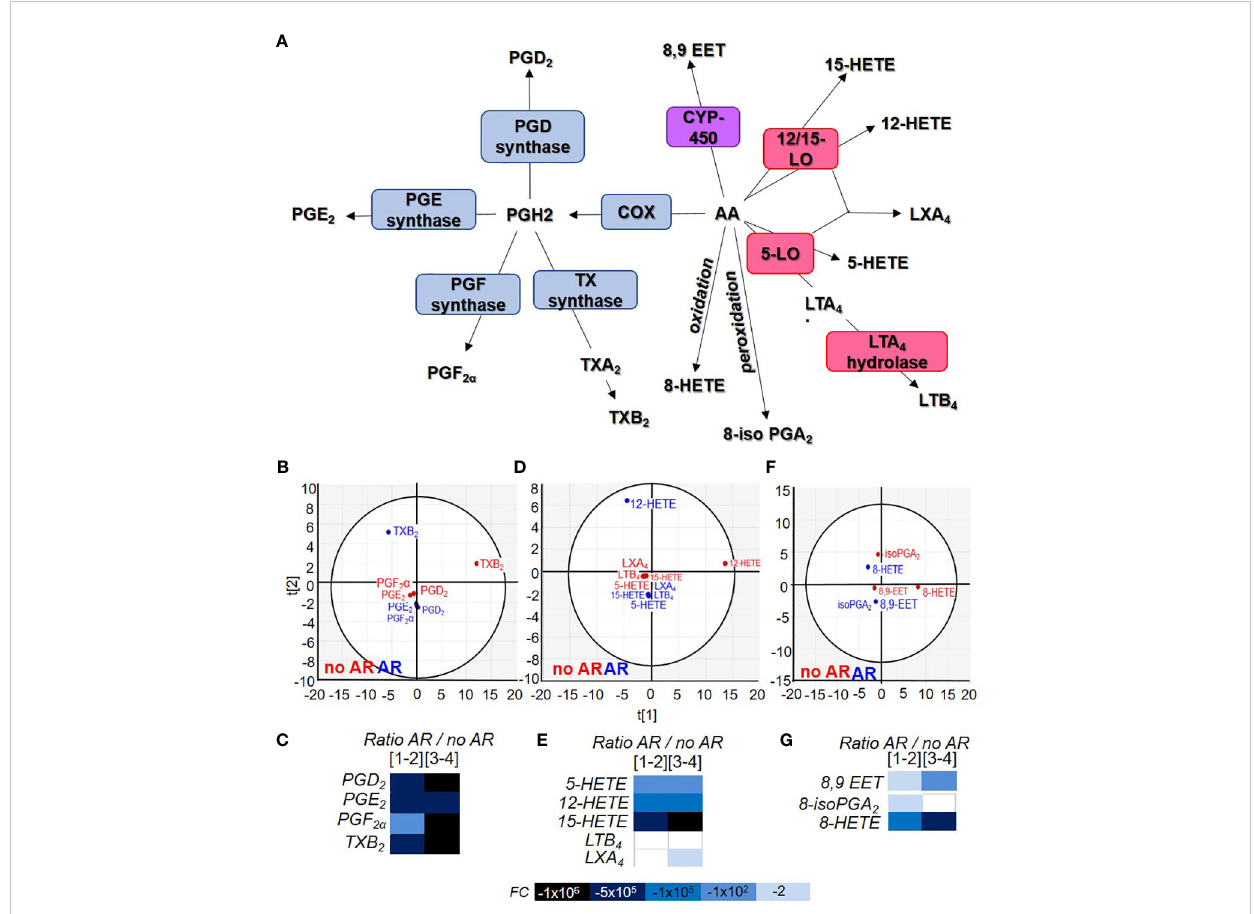
FIGURE 4 Comparison of acid arachidonic metabolite contained in Single Donor Apheresis during storage and in the event of an adverse reactions. (A) Flowchart illustrating the generation of eicosanoids from arachidonic acid (AA) through cyclooxygenase (COX), prostaglandin (PG) synthase, thromboxane (TX) synthase, lipoxygenase (LO) and cytochrome P450 (CYP-450). (B, D, F) Two-dimensional score plot of a principal component analysis of COX products from AA (B) , LO products from AA (D) and CYP-450/oxidation/peroxidation of AA (F) in SDA-PC without occurrence of AR (red) and with occurrence of AR (blue), taking all storage times into account. (C, E, G) Heat map represents fold change in mean eicosanoid (COX products C), (LO products E) and other products (G) expression between SDA-PC with occurrence of AR and from SDA-PC without occurrence of AR for different storage times reported on the heat map. Prostaglandin D 2 (PGD 2 ), prostaglandin E 2 (PGE 2 ), prostaglandin F 2 a (PGF 2 a ), thromboxane B 2 (TXB 2 ), 8iso-prostaglandin A 2 (8iso-PGA 2 ), prostaglandin A 1 (PGA 1 ),8-hydroxyeicosatetraenoic acid (8-HETE), 12-hydroxyeicosatetraenoic acid (12- HETE), 15-hydroxyeicosatetraenoic acid (15-HETE), 5-hydroxyeicosatetraenoic acid (5-HETE), leukotriene B 4 (LTB 4 ), lipoxin A 4 (LXA 4 ), 8,9- epoxyeicosatrienoic acid